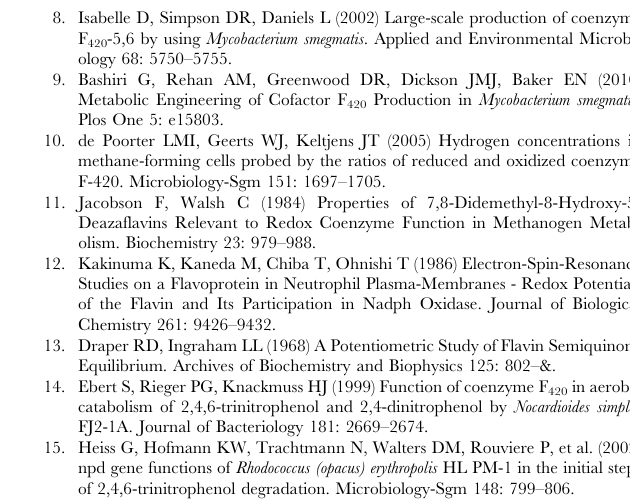
Figure S1 Phylogenetic tree of FDR-A enzymes used in this study. (TIF) Figure S2 SDS-PAGE of his-tagged FDR-A enzymes from ten different Actinomycetales species. Whole cell (WC) and soluble protein (S) fractions of each protein were recombinantly expressed in E. coli BL21-AI cells and separated on a 10% SDS- PAGE with a Biorad (Australia) Precision Plus Protein Standards molecular weight marker (M). E. coli BL 21- AI cells were used as control (control), The expressed proteins were: FRAAL1295 (1), SCO7200 (2), A20C1_10575 (3), RER_09240 (4), nfa28980 (5), JNB_17993 (6), RER_34350 (7), RHA1_ro00484 (8), Mvan_5261 (9) and Rv3547 (10). (TIF) Figure S3 Comparison of putative deazaflavin pocket and glutamate chain binding sites in the FDR-As. Amino acid substitutions within the putative deazaflavin binding pocket as well as the c -glutamate chain are shown in comparison to the crystal structure of MSMEG_3356. Conserved amino acids compared with MSMEG_3356 are shown with an * (in red). FDR-A enzymes showing specific activities above 10,000 nmol/ min/ m mol enzyme are highlighted with a grey background. FDR- A enzymes are arranged in the same sequence as in Figure 2. (TIF) Table S1 Primers used for protein expression work. (DOCX) Table S2 Genes expressed in this study. Table S3 Genes observed in the same reading frame as FDR